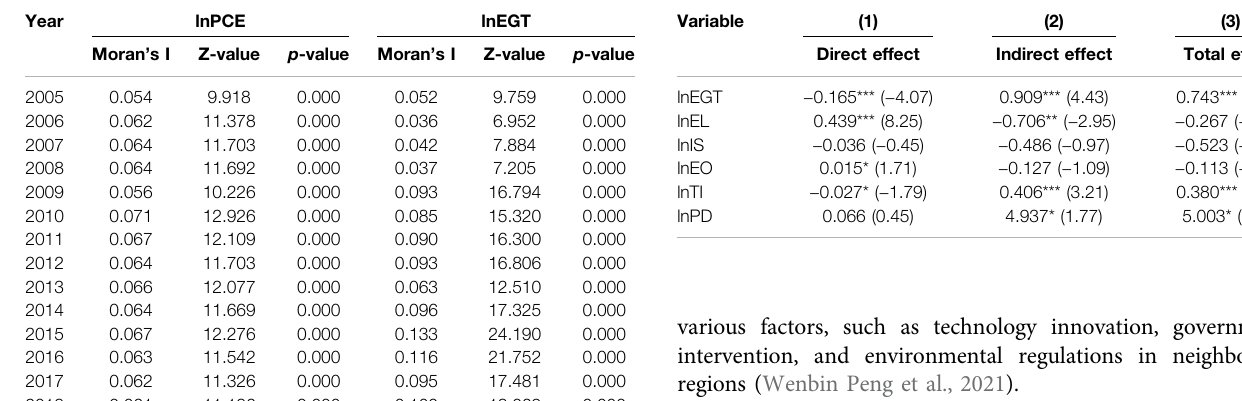
TABLE 2 | Global Moran ’ s I index of lnPCE and lnEGT .